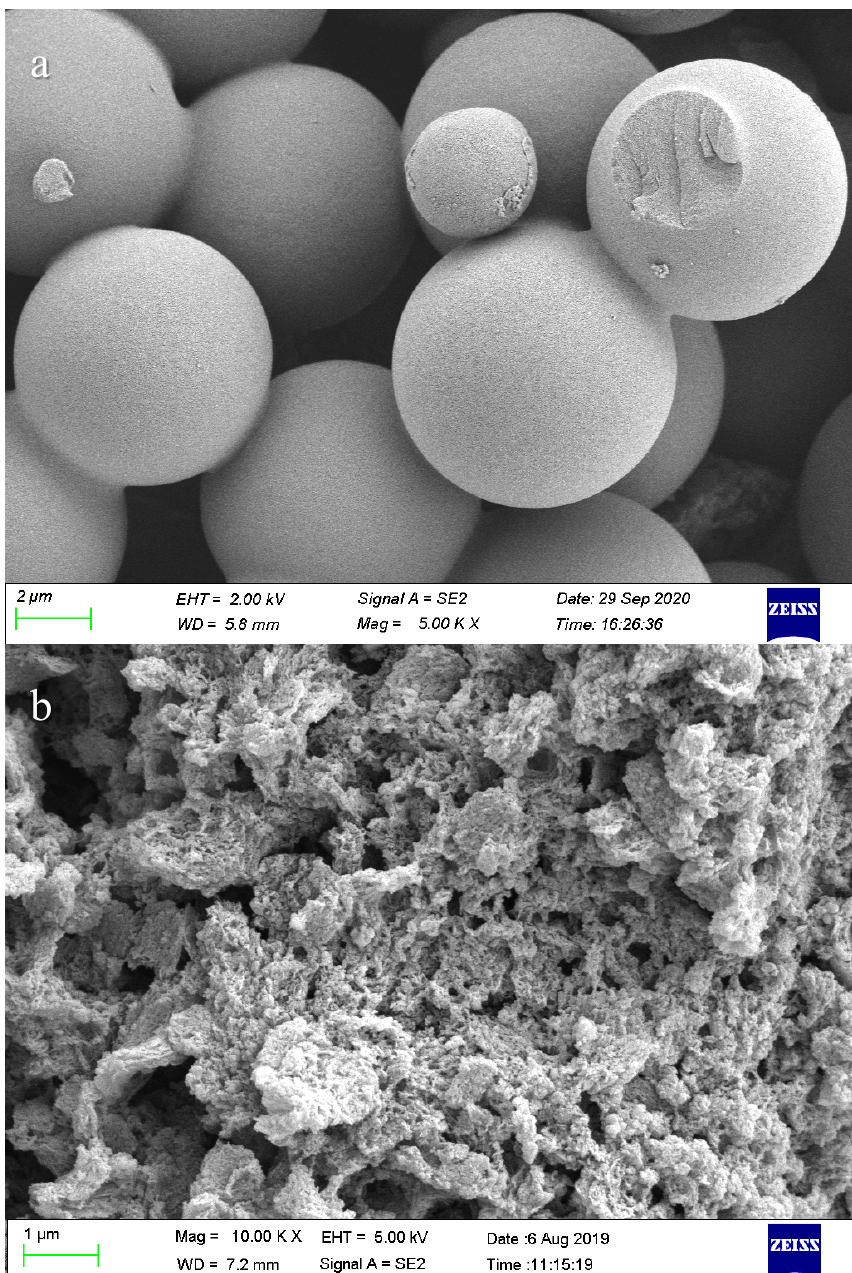
Figure 1. Scanning electron microscopy (SEM) images of samples: hemicelluloses hydrothermally treated with citric acid (HTC) ( a ) and HTC-NH 2 ( b ).